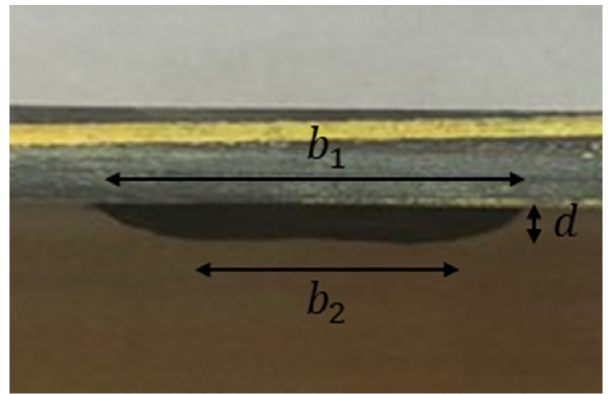
Figure 8. HAZ shape obtained by experimental